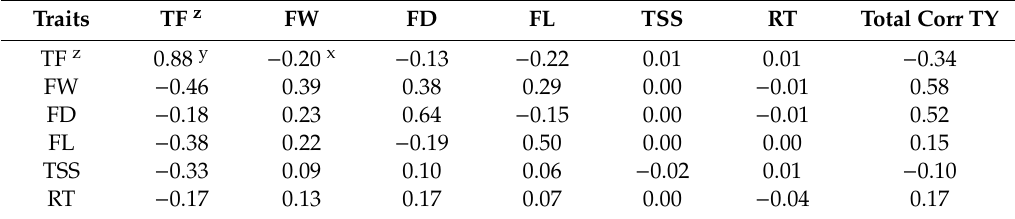
Table 4. Path analysis with path coe ffi cient of traits onto TY on twenty watermelon genotypes evaluated at Uvalde and Weslaco TX in 2018 and